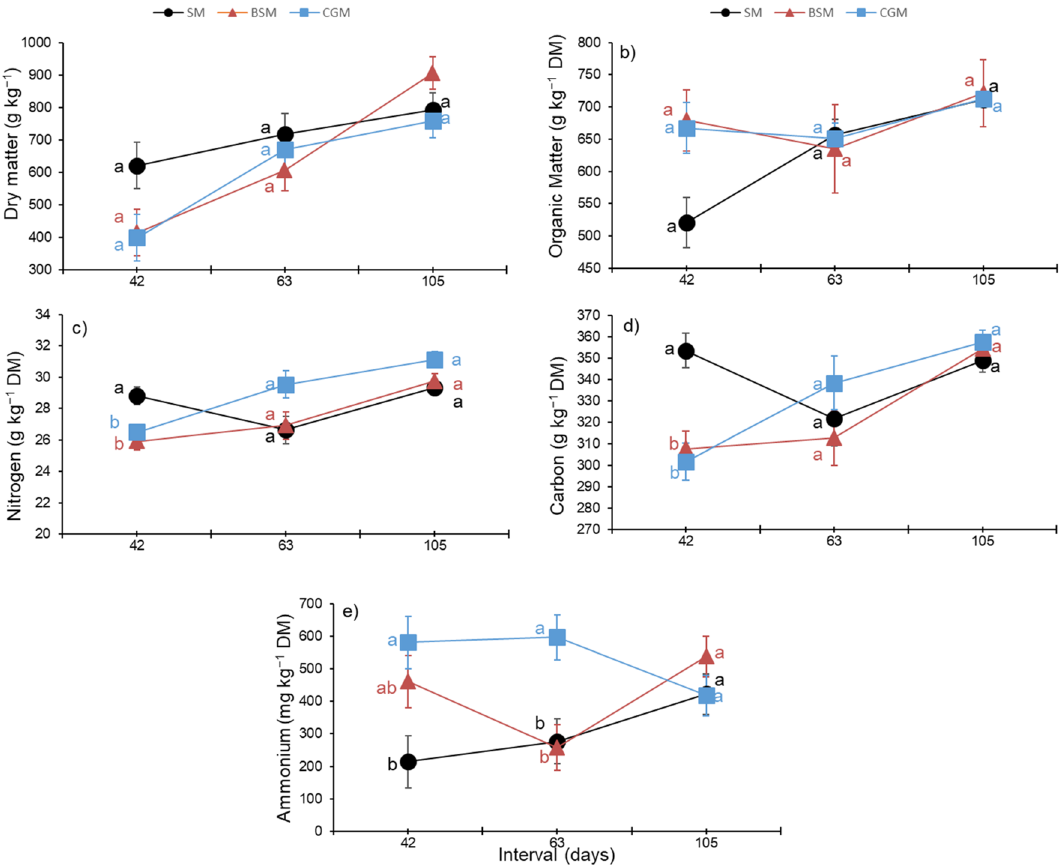
Figure 3. Dry matter, organic matter, N, C and NH 4 + content of the manure, deposited in the soil, of Nellore cattle fed with rumen undegradable protein source during the finishing phase in feedlot. SM = manure of animals fed soybean meal as a source of rumen degradable protein (RDP), BSM = manure of animals fed by-pass soybean meal as a source of rumen undegradable protein (RUP), CGM = manure of animals fed corn gluten meal as a source of RUP. Different letters represent significant differences by Tukey’s Test (P ≤ 0.05) within the